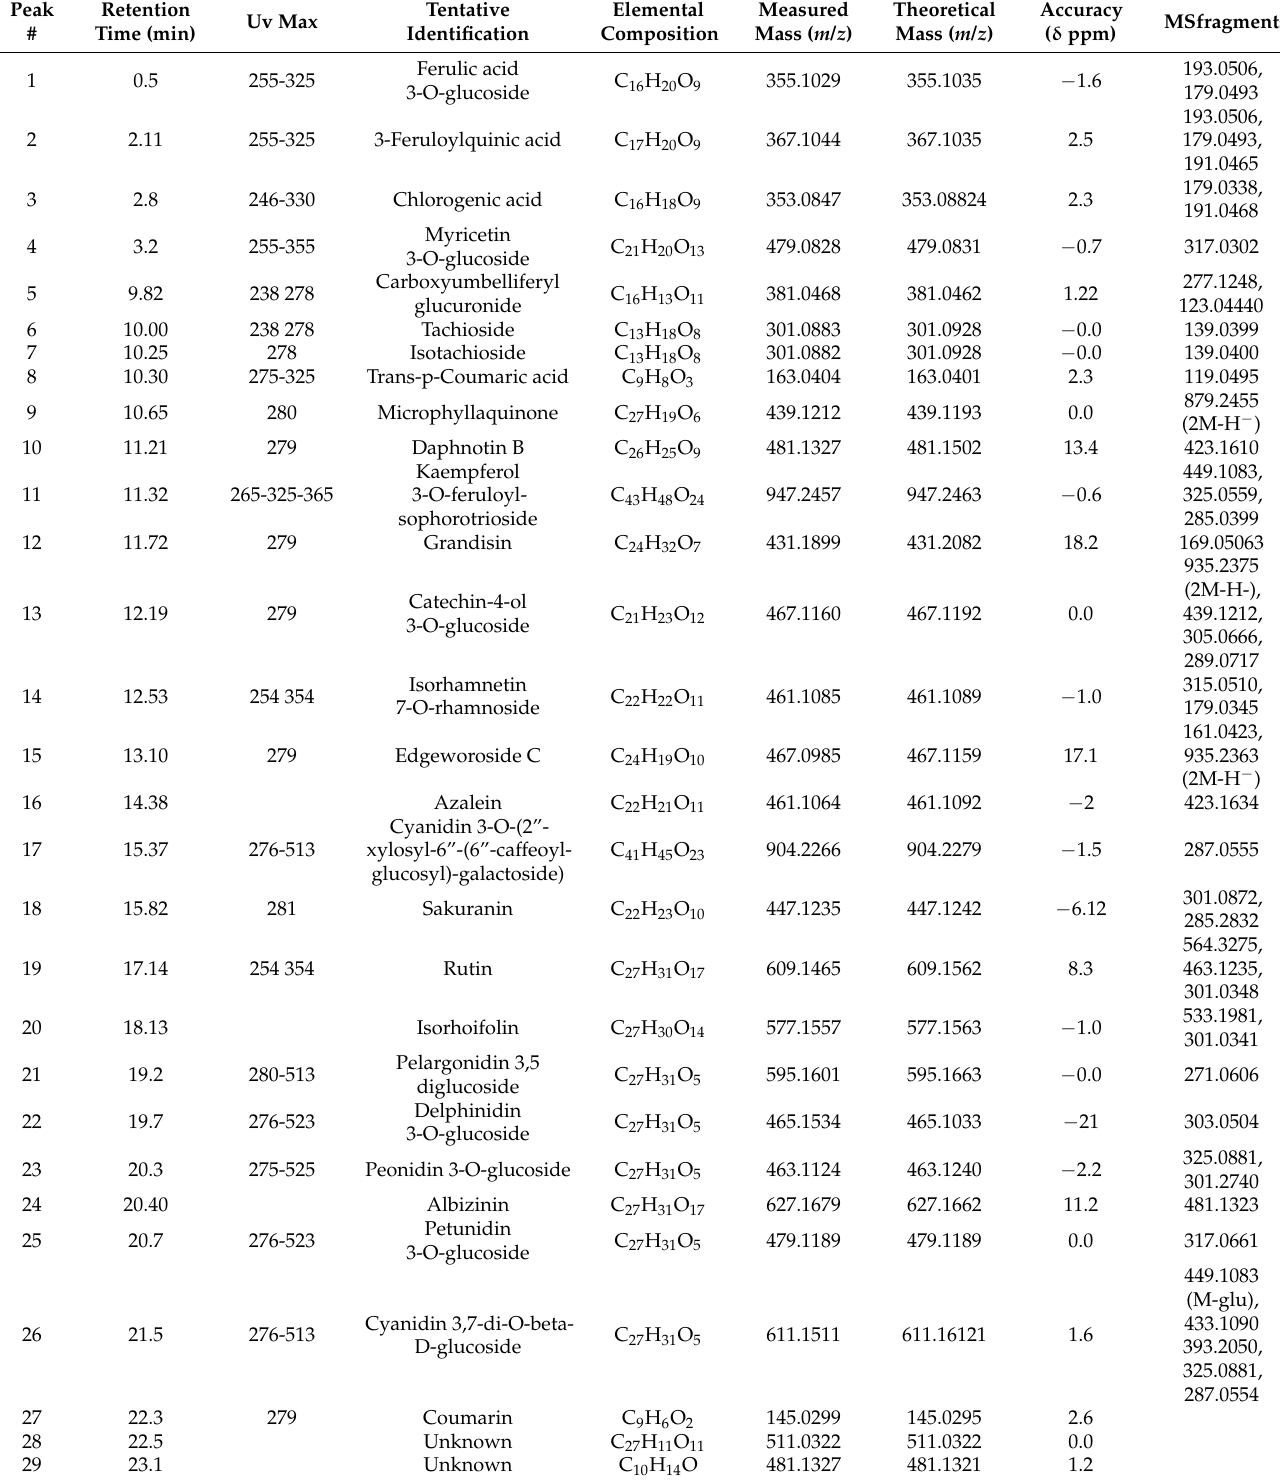
Table 2. Identification of compounds via UHPLC MS of A. dentata